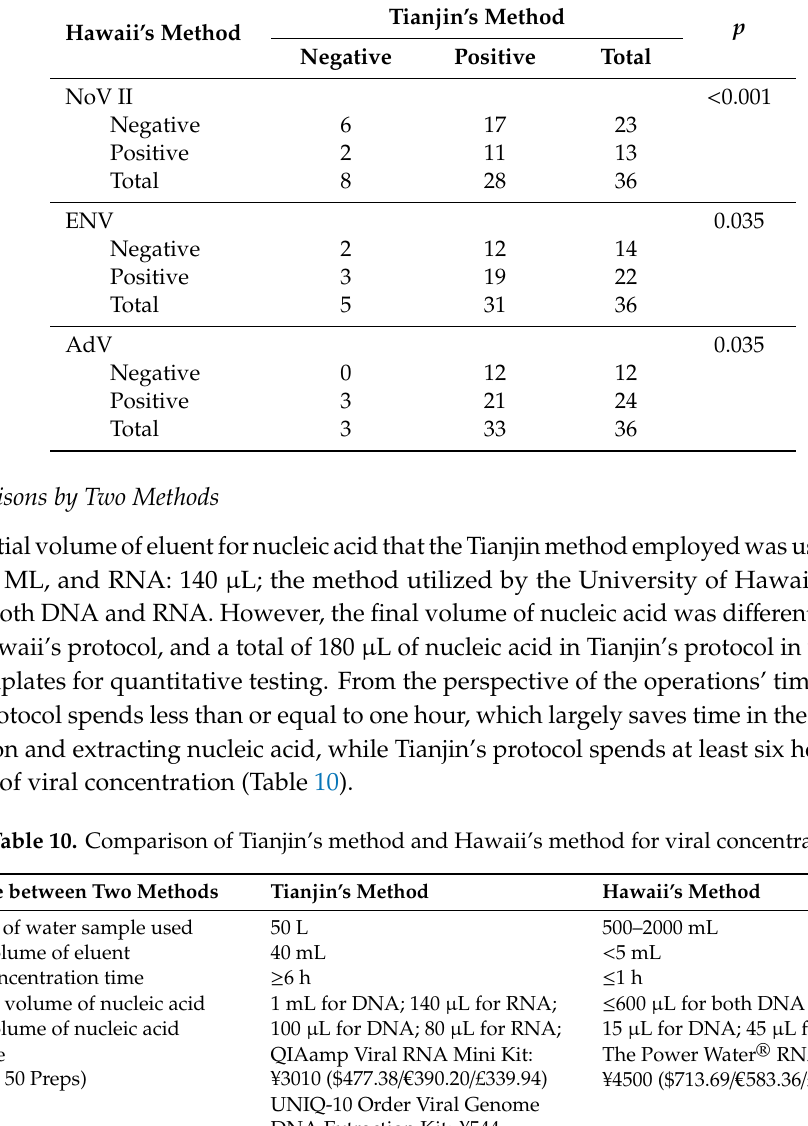
Table 9. Comparison the detection of enteric viruses through Tianjin’s method and Hawaii’s method by McNemar Test.